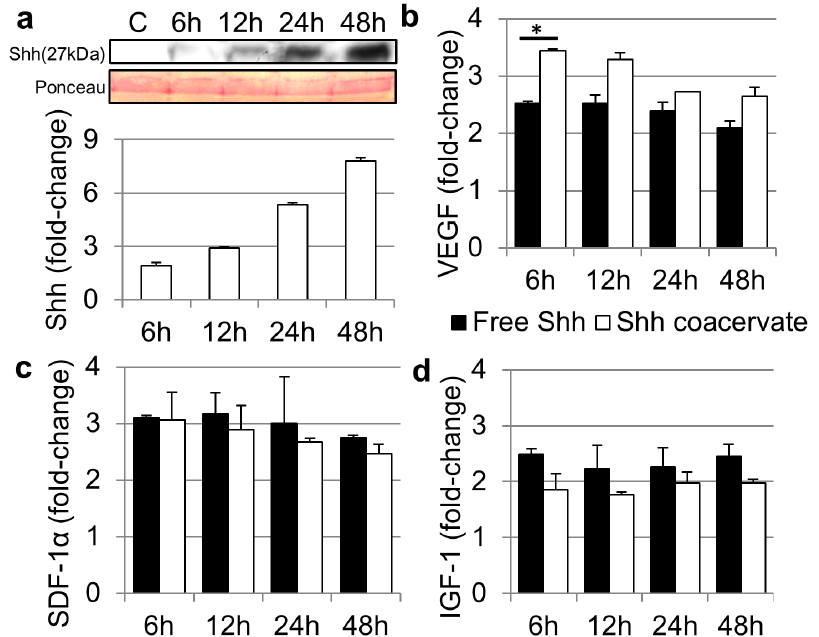
Figure 3. Shh-stimulated cardiac fibroblast signaling. Near-confluent cardiac fibroblasts were incubated with Shh, free or in the coacervate, and growth factor levels in the conditioned media were assessed after 6, 12, 24, and 48 h. Data is presented as a fold-change from the stimulation media (C). Bars indicate means 6 SD. ( a ) Quantification of Shh concentration in the cardiac fibroblast-conditioned media by western blot. Ponceau-S staining of protein bands near 27 kDa is shown as the loading control. ( b ) Quantification of VEGF in the cardiac fibroblast-conditioned media by indirect ELISA, * P , 0.05. ( c ) Quantification of SDF-1 a in the cardiac fibroblast-conditioned media by indirect ELISA. ( d ) Quantification of IGF-1 in the cardiac fibroblast-conditioned media by indirect ELISA.